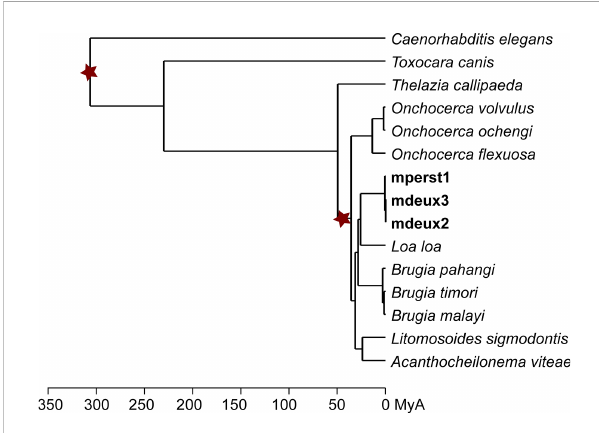
FIGURE 2 Evolutionary analysis of Mansonella sp “ DEUX ” and M. perstans .